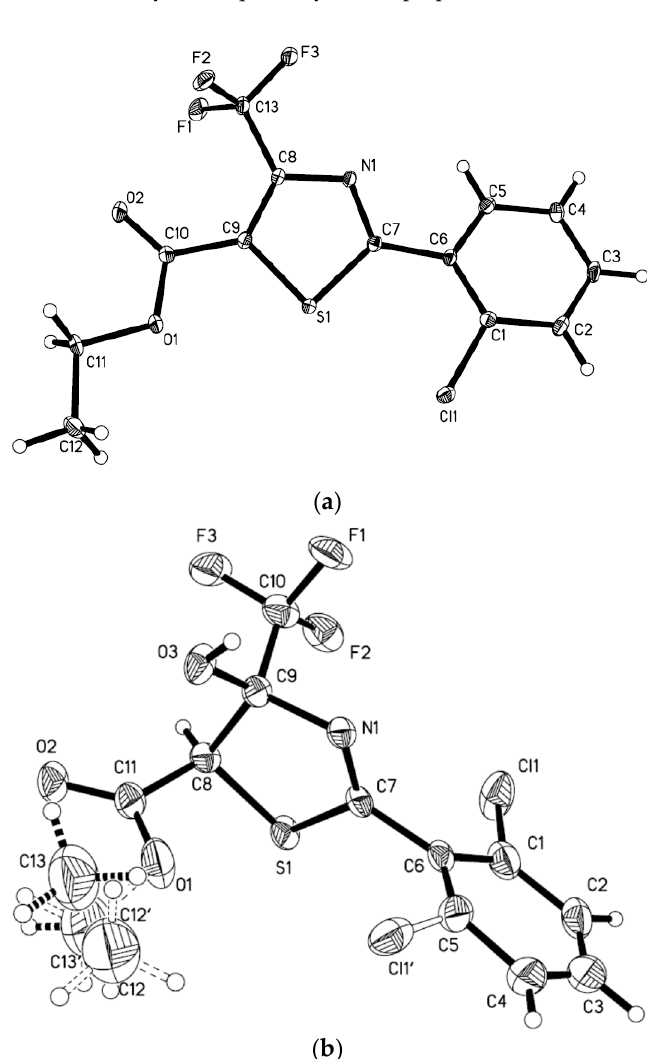
Figure 1. The crystal structure of 4b ( a ) and 5b ( b ).